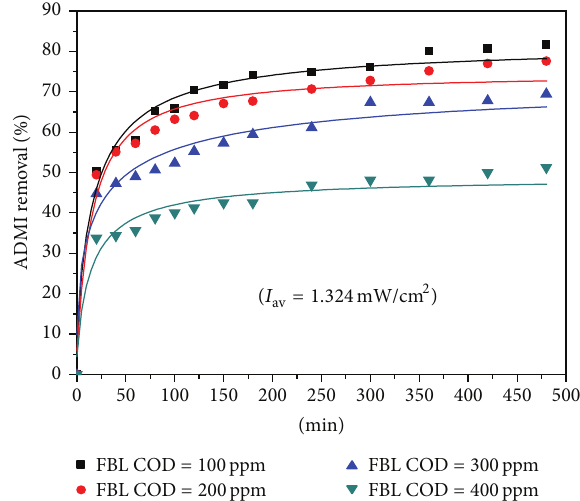
Figure 8: ADMI removal % versus time with Ni-Zn ferrite/TiO 2 (COD | 𝑡=0 = 100–400 ppm) to treat FBL dye (dosage = 5 g/L; 𝐼 av = 0.1324 mW/cm 2